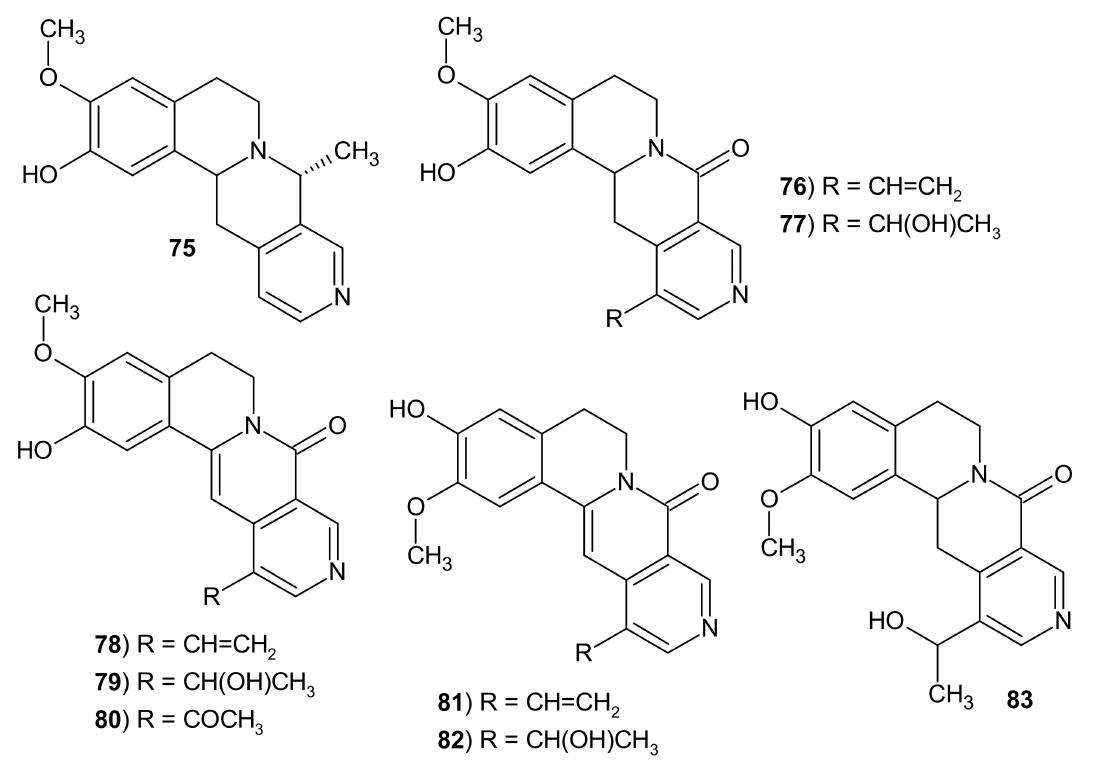
Figure 25. Structures of alangium alkaloids 75 – 83 .